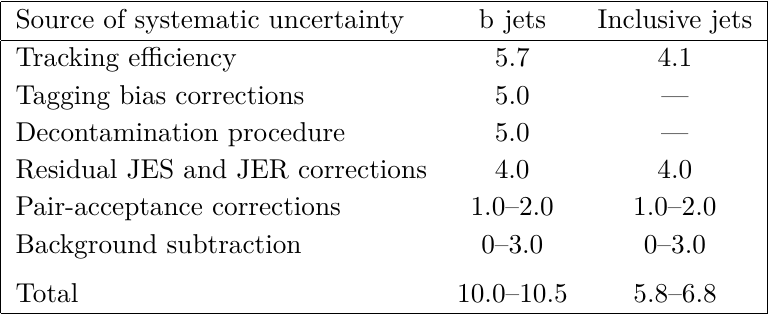
Table 1 . Systematic uncertainties in percentage for the measurements of the jet-track correlations. Where an uncertainty range is given, the upper edge of the range corresponds to the bin with the smallest p trk values. The sources from the decontamination and tagging bias are exclusive for b T